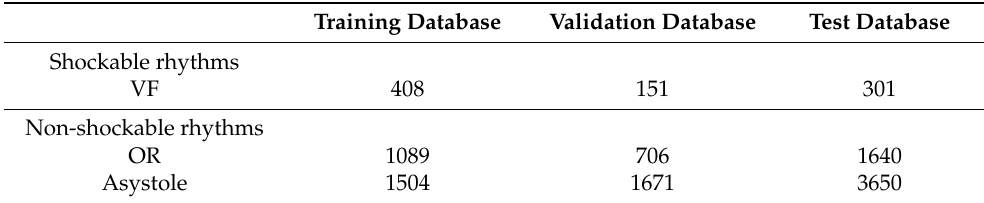
Table 1. Number of ECG strips with CC artifacts extracted from OHCA interventions in different rhythm categories. Independent interventions from different patients were used in the training, validation and test databases.